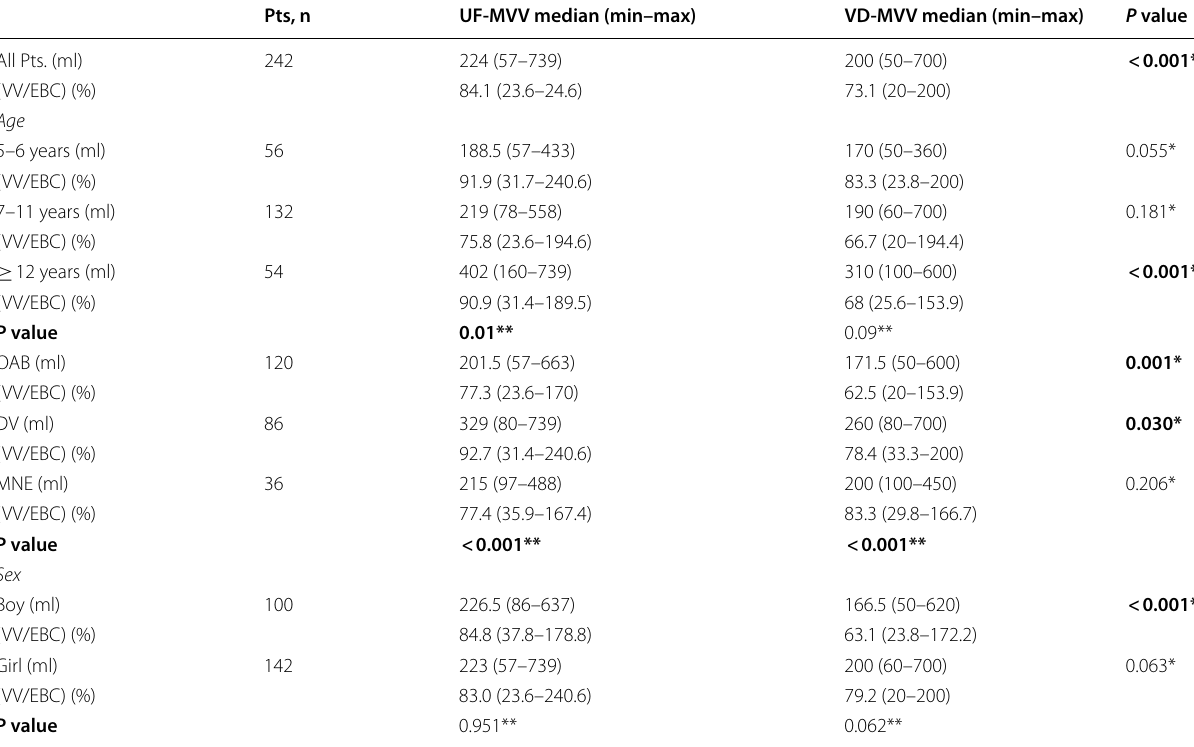
Table 1 Comparison of MVV reported by 48-h VD and UF in the entire study population and stratified according to the age, LUTD subtypes, and